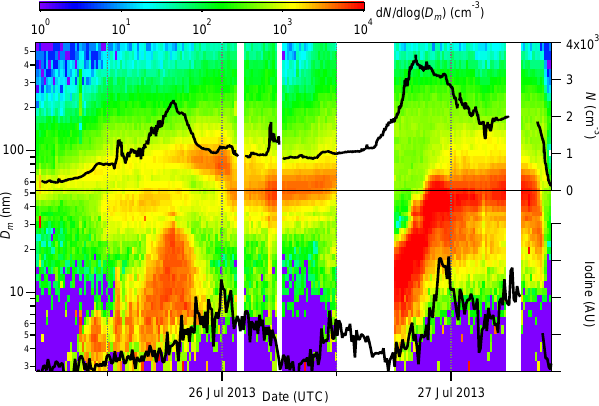
Figure 4. Size-resolved number concentrations (d N/ dlog (D m )) from a differential mobility particle sizer (DMPS) as a function of electrical mobility diameter ( D m ) , total number concentrations ( N) from a condensation particle counter (CPC) and uncalibrated iodine ion concentrations from an AMS based on the signal at m/z = 127 (I + ) during the main case study. White areas in the DMPS data show periods of ship influence or when the instrument was not sam- pling ambient